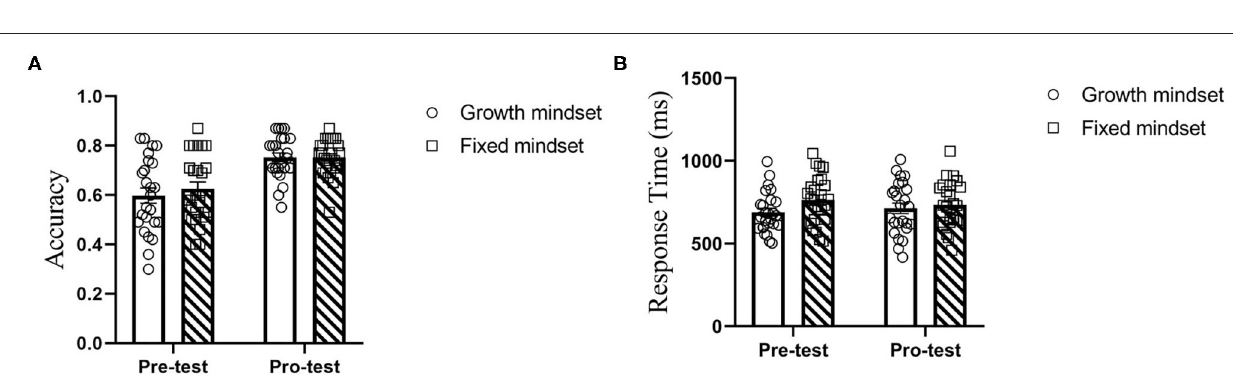
FIGURE 5 | The difference between the growth group and the fixed group in the 2-back task [accuracy (A) and response time (B)